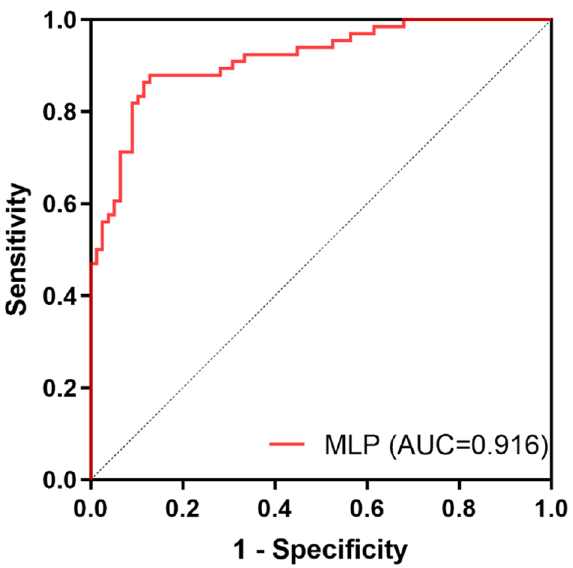
Figure 5. ROC curve of the neural network model (MLP).